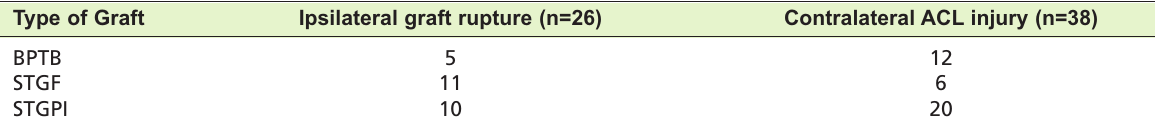
Graft type in Group I between ipsilateral and contralateral ACL Table III: